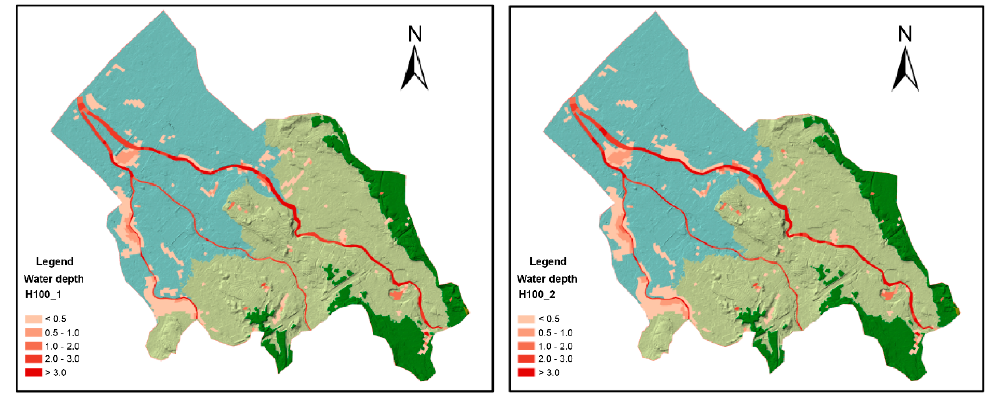
Figure 9. Example of flood simulations (maximum inundation depth) under different rainfall scenarios using a 100-year return period.